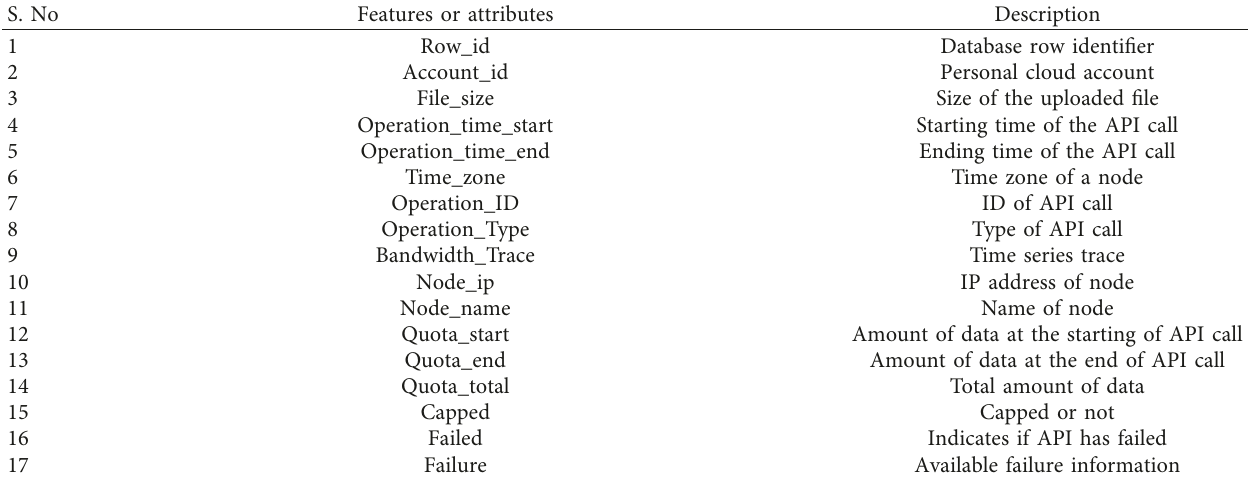
Table 2: Column fields description.